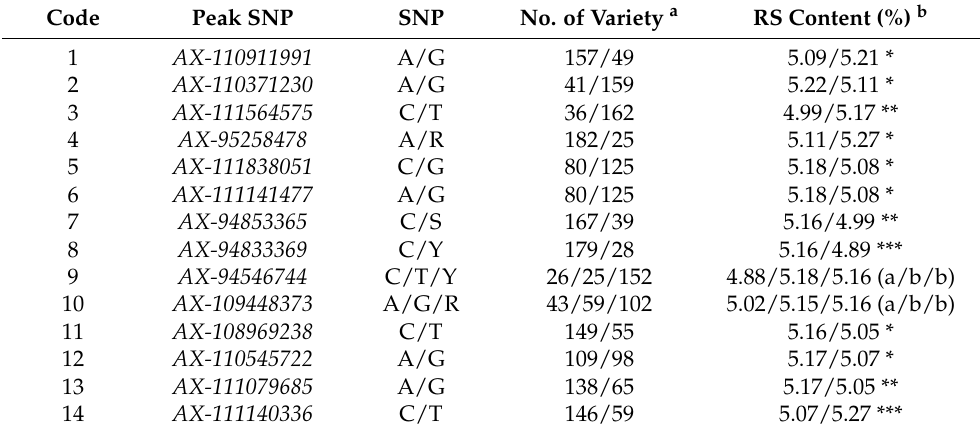
Table 2. Evaluation of the superior alleles in significant